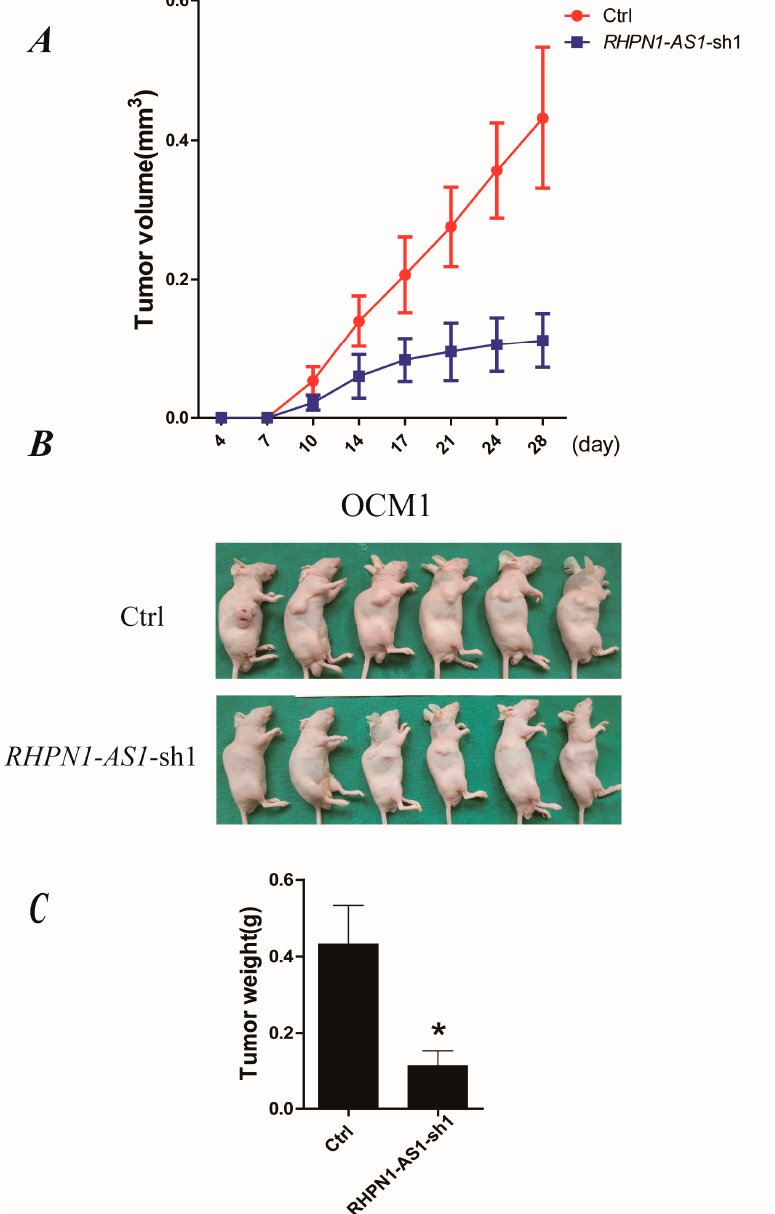
Figure 4. Depressed expression of RHPN1-AS1 repressed UM cell growth in vivo. ( A ) Tumor volume growth curves. Each data point represents the mean ± SD; ( B ) RHPN1-AS1 knockdown OCM1 and control cells were injected into nude mice subcutaneously. Representative images of tumor growth 28 days after subcutaneous injection; ( C ) Mean tumor weights four weeks after inoculation. * p < 0.05.